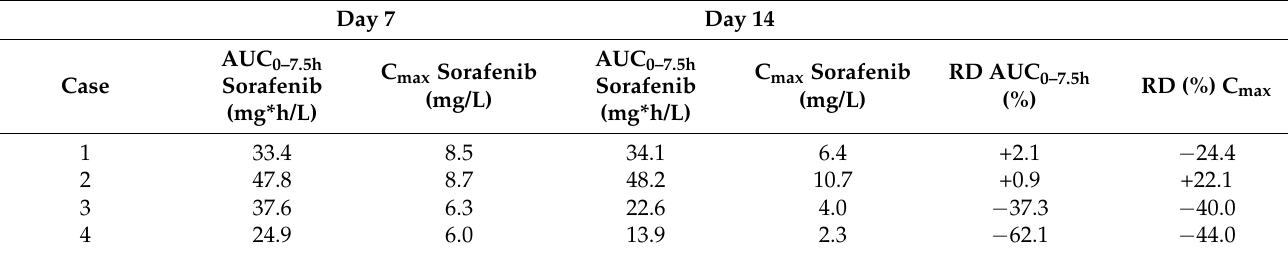
Table 1. AUC 0–7.5h and C max of each individual